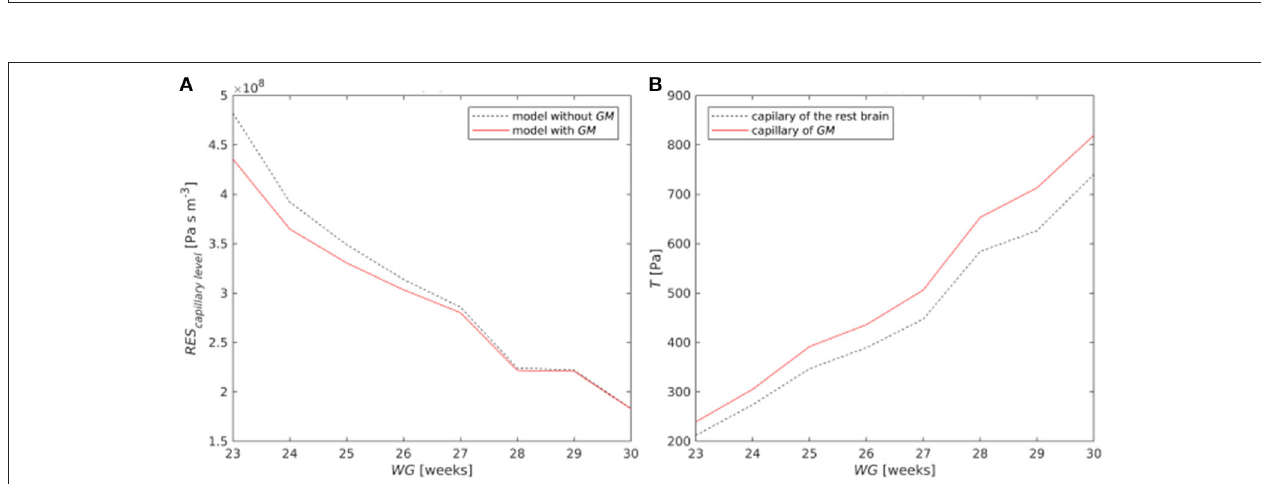
Frontiers in Neurology | www.frontiersin.org